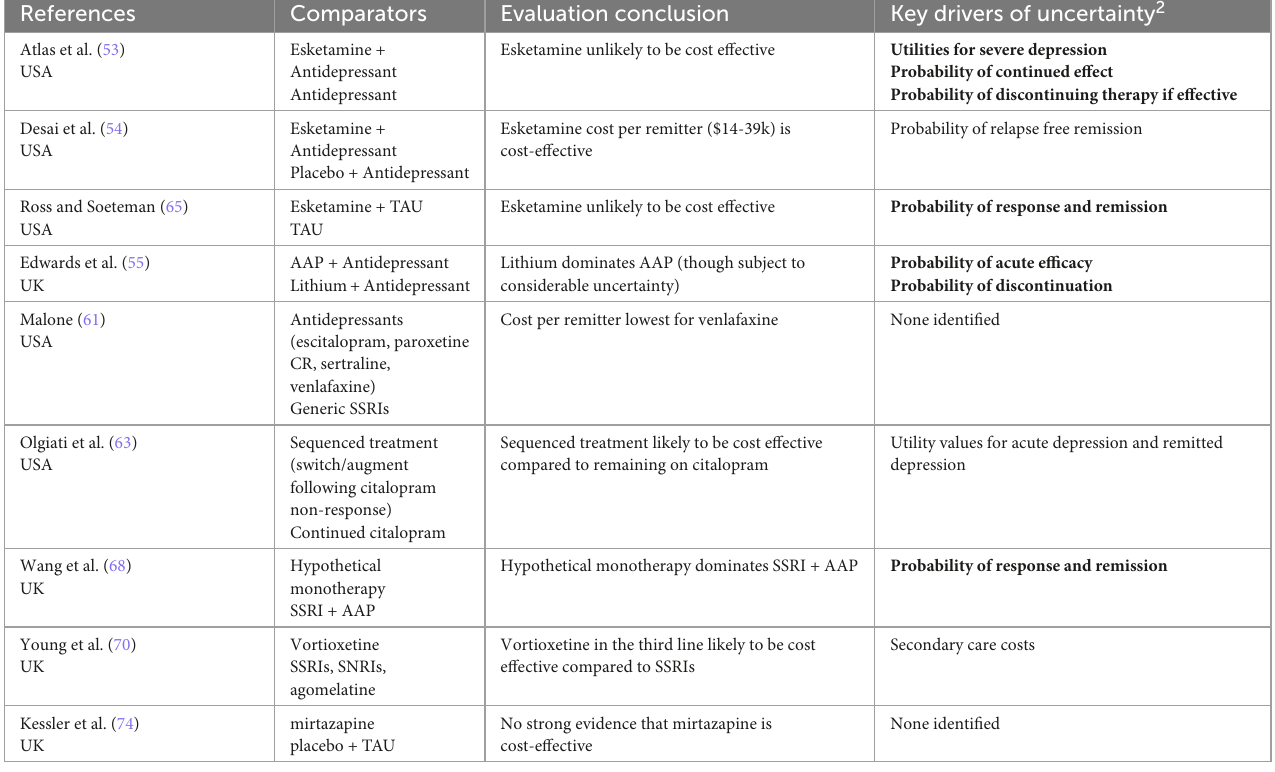
TABLE 4B Summary of authors’ conclusions, and key drivers of uncertainty for economic evaluations of pharmacological interventions.